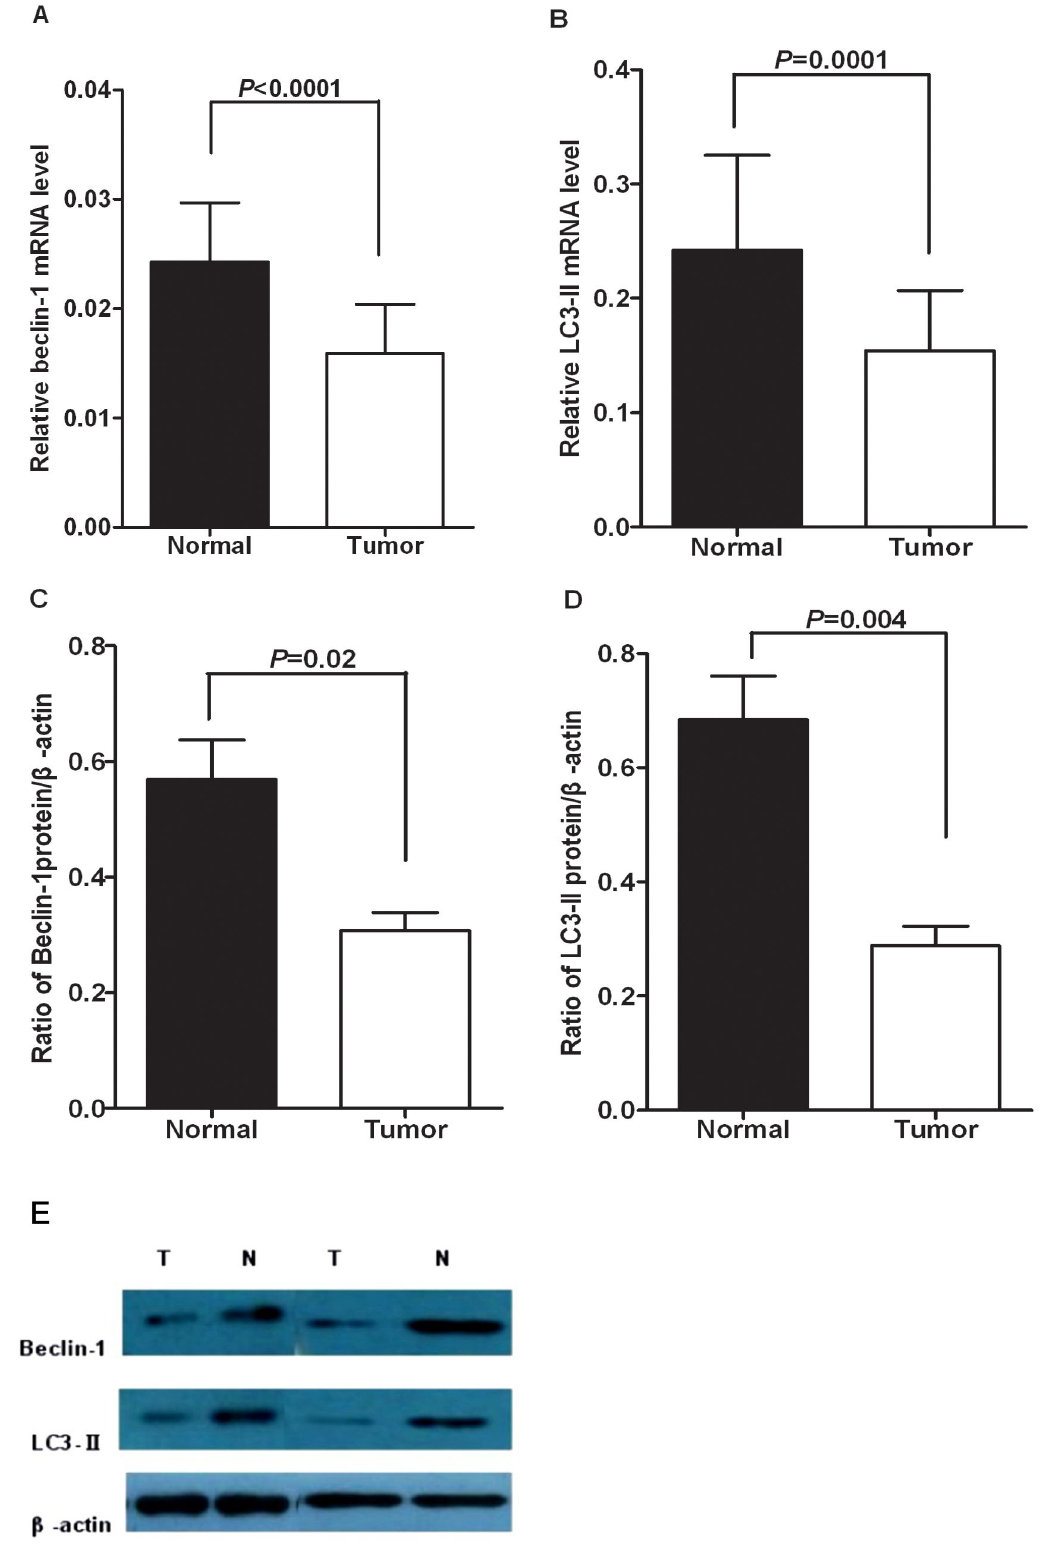
Figure 2. Expression of beclin-1 and LC3-II in human hypopharyngeal squamous cell carcinoma (HSCC) tissues. doi: 10.1371/journal.pone.0069038.g002 PLOS ONE |